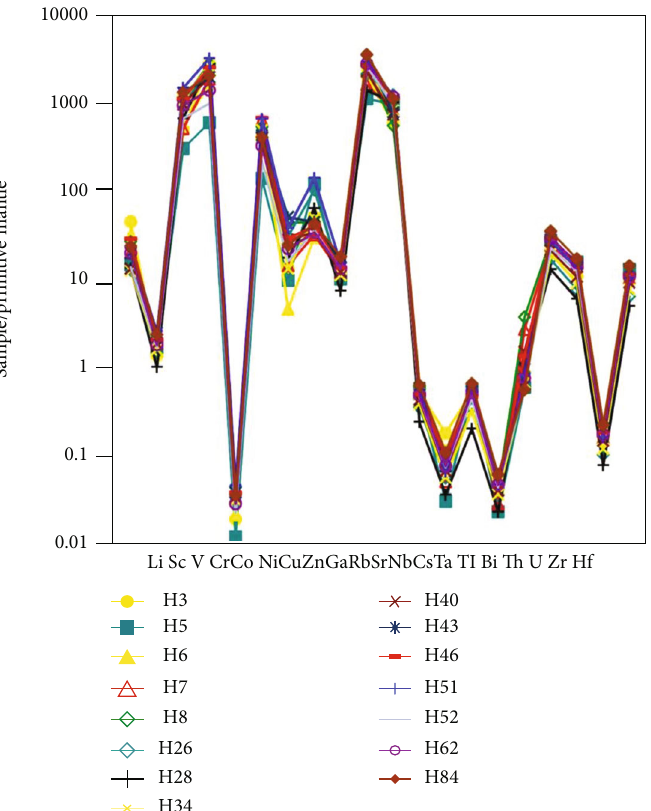
Figure 6: Primitive standard spider graph of trace elements of Daping gold deposit. The values for primitive mantle are from